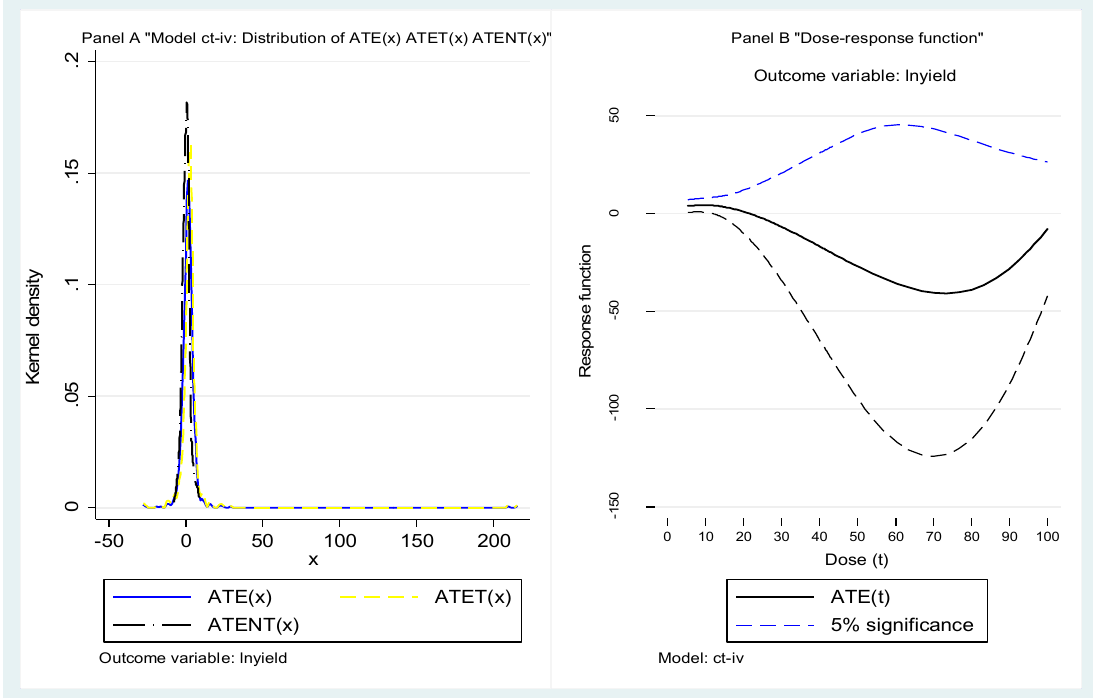
Figure 1. Distribution of ATE(x), ATET(x), and ATENT(x) and dose–response function for chemical fertilizer on rice yield.